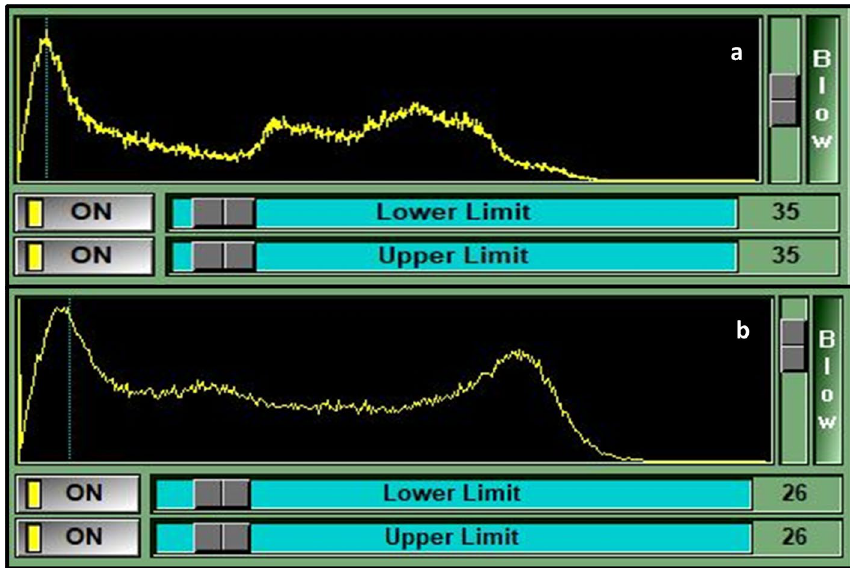
Figure 1. Muscle histograms. Example of two histograms demonstrating single ( a ) and triple ( b ) muscle peak values. Vertical dotted lines intersect the histogram to indicate the peak muscle signal values (i.e., 35 &